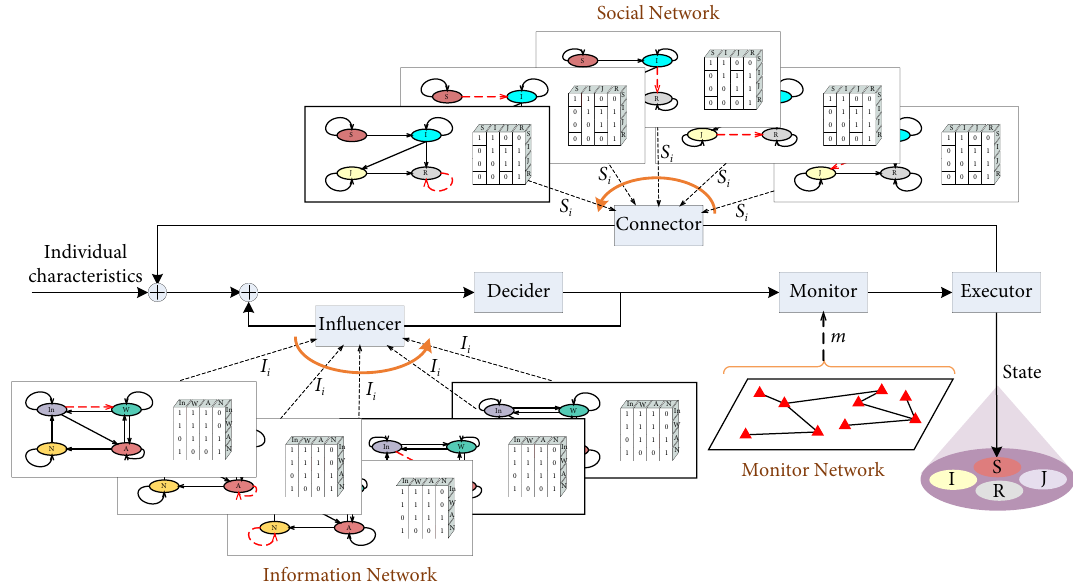
Fig. 4 Digital-self unit structure.